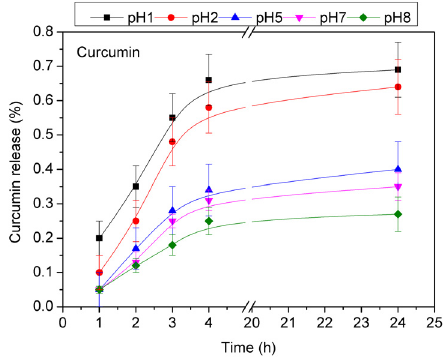
Figure 9. Curcumin release from pure curcumin powder.